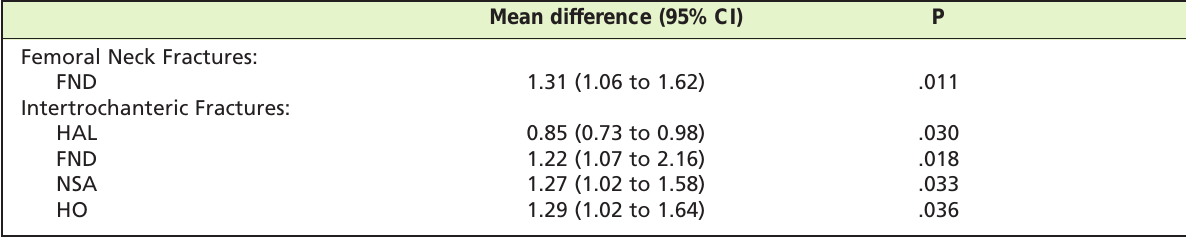
Predictors of femoral neck and intertrochanteric fractures Table IV: Mean difference (95%